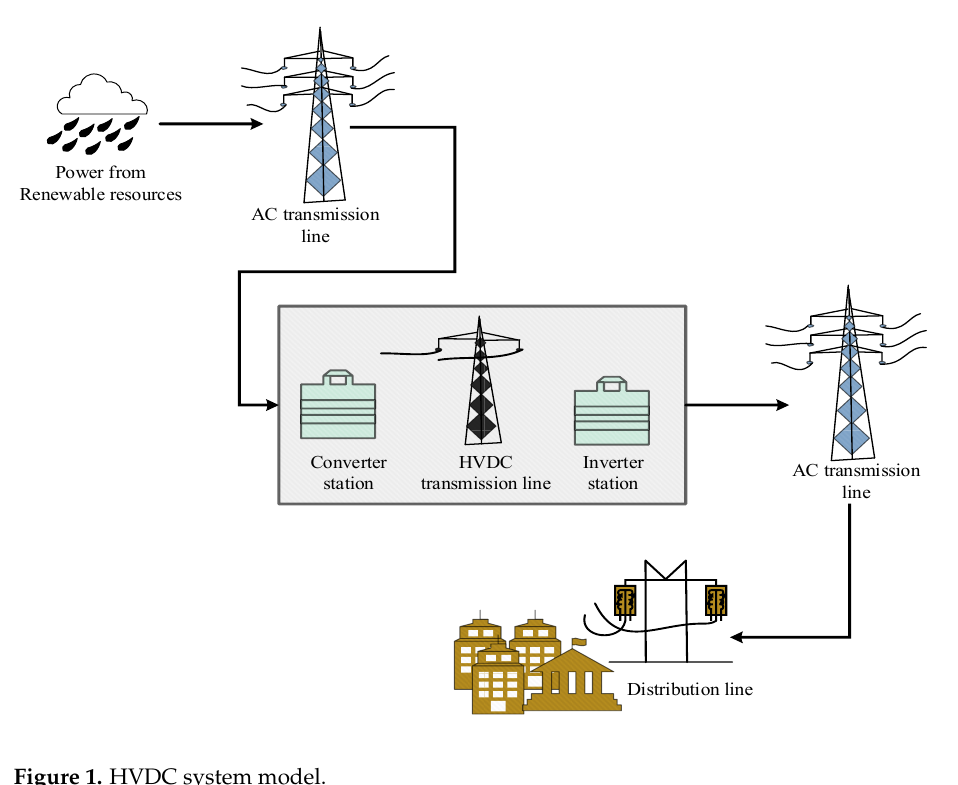
Figure 1. HVDC system model.